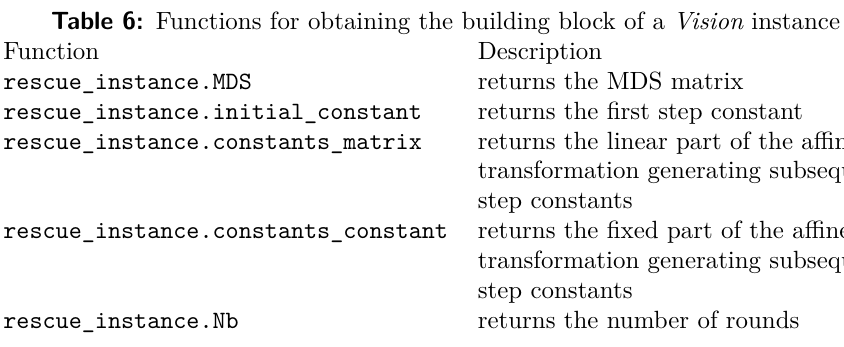
Table 6: Functions for obtaining the building block of a Vision instance Function